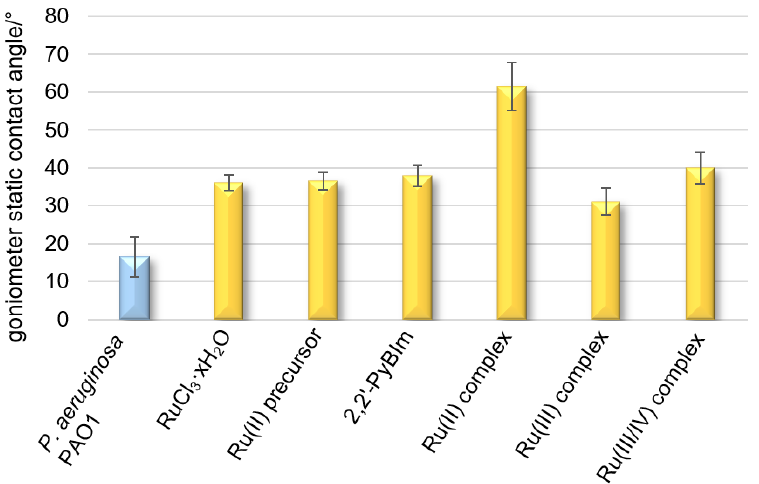
Figure 5. Wettability (contact angle) of P. aeruginosa PAO1 with original surface and with the addition of the Ru complexes.